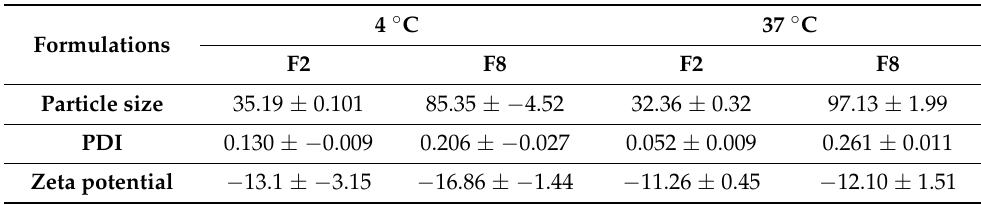
Table 8. Mean particle size, PDI, and zeta potential values of the PF-loaded SNEDDS formulations after 6 months of storage at 4 ◦ C and 37 ◦